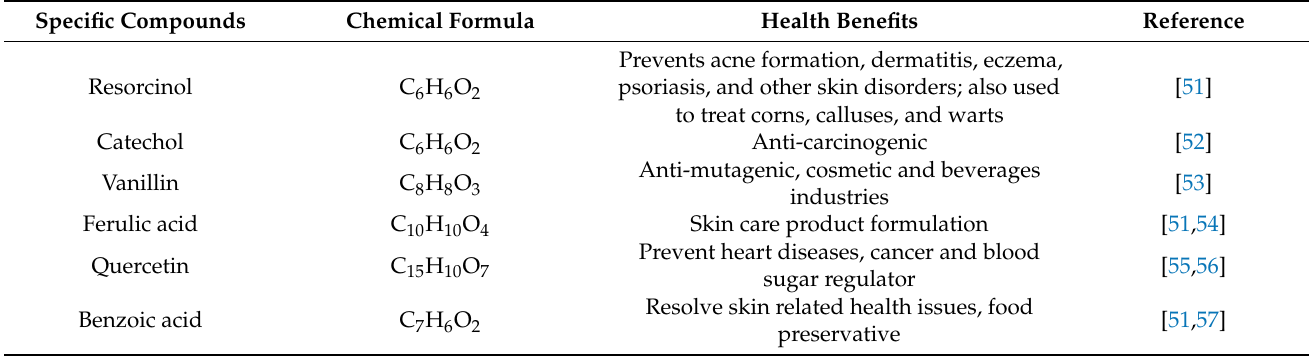
Table 3. Specific compounds in rye extracts and their health-benefiting